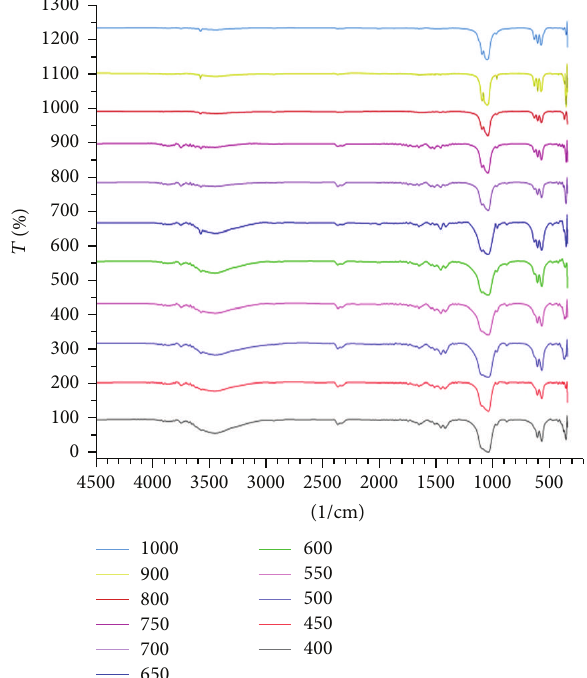
Figure 7: FT-IR spectra of synthesis results in various temperatures (400–1000 ∘ C).